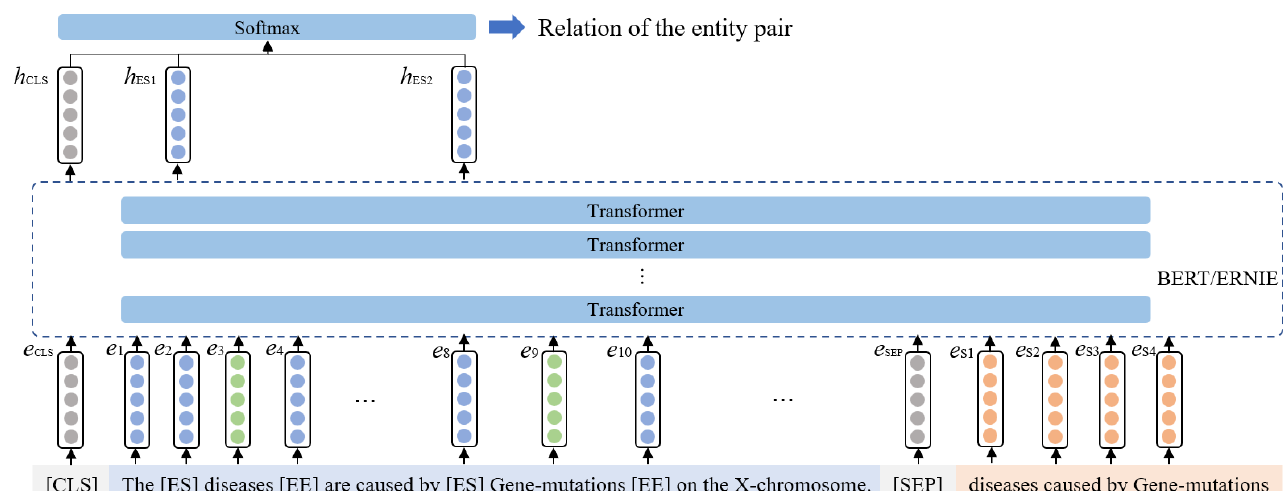
Figure 7. The final architecture of the proposed model. For the input of this model, sequential data and structural data are concatenated with the [SEP] token to form the new input